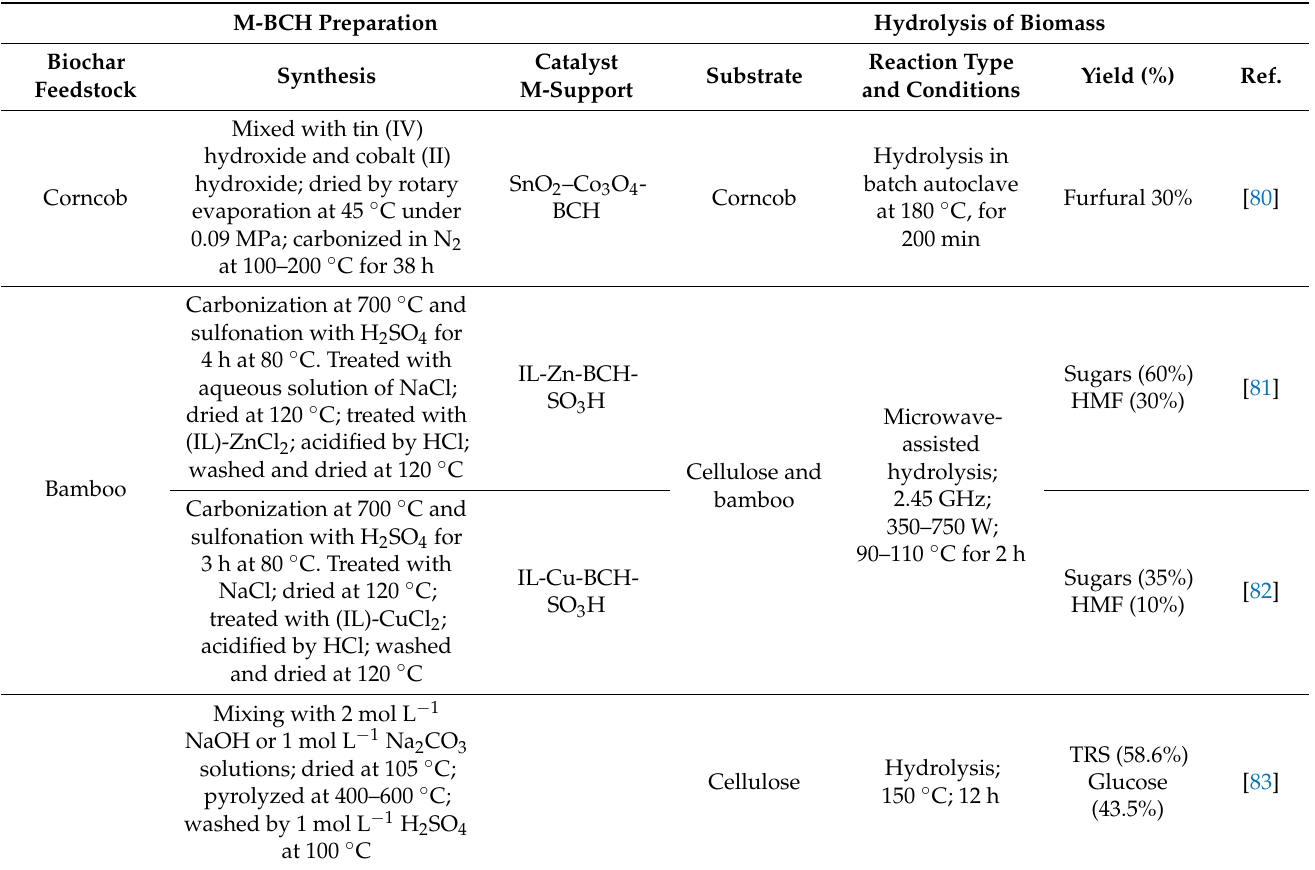
Table 5. Metal-supported biochar-based catalysts used in hydrolysis of biomass